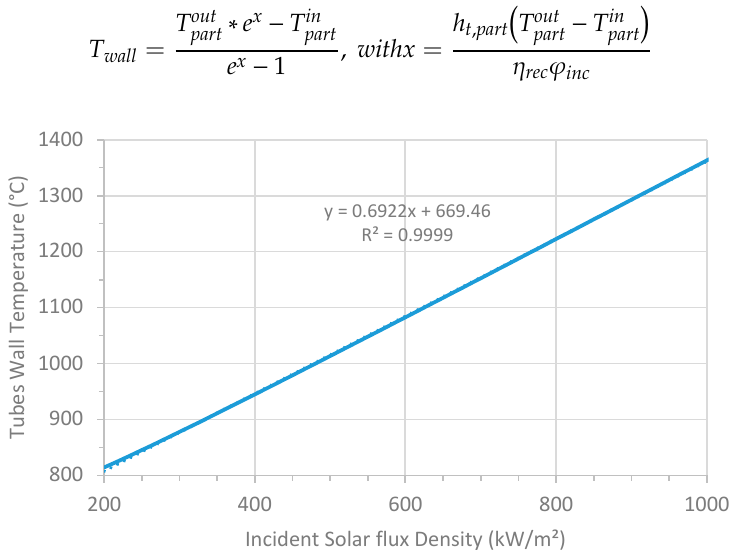
Figure 4. Evolution of the tubes wall temperature as a function of the incident solar flux density, following equation 6 and with a targeted receiver efficiency of 85%.